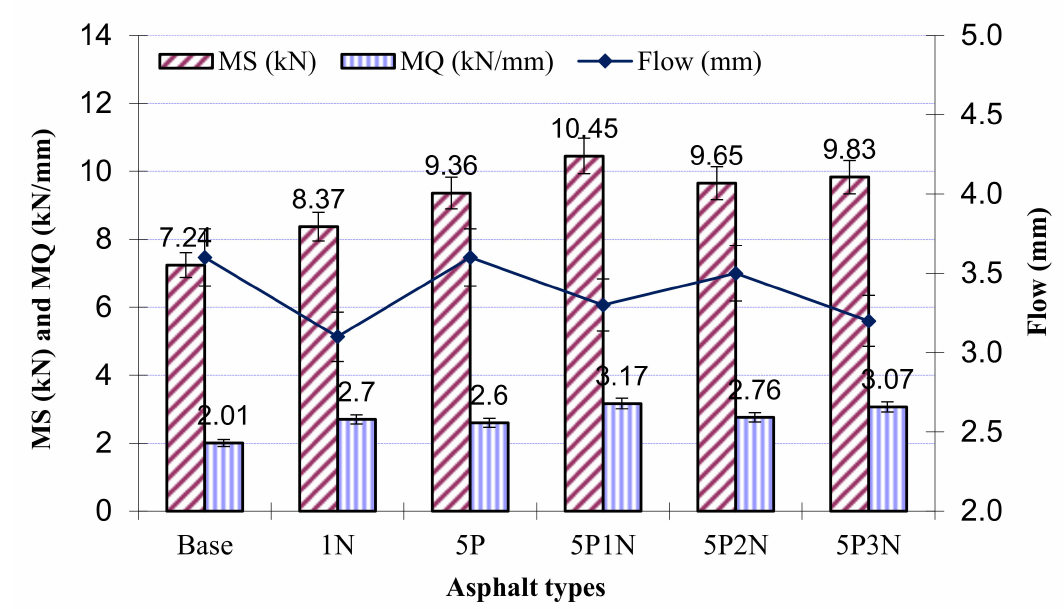
Figure 8. Results of MS experiment.